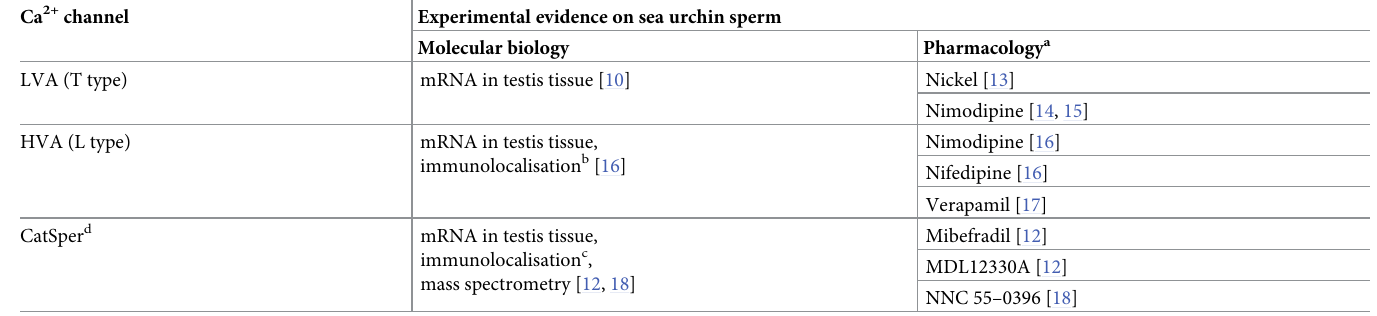
Table 1. Summary of experimental evidence on the main calcium channels proposed in the pathway activated by SAPs. a It is worthwhile to mention that out of the pharmacological blockers listed, none of them are 100% specific to the associated channels. b Antibody raised against a polypeptide of the α subunit in rat, which also recog- nises the homologous version in mouse and human sperm. c Antibody raised against pore-forming subunit polypeptides of A. punctulata [12] and S. purpuratus [18]. d It is of note that direct electrophysiological recordings for this ion channel have not been achieved in mature sea urchin spermatozoa compared with the homologous complex in mouse, human and macaque spermatozoa